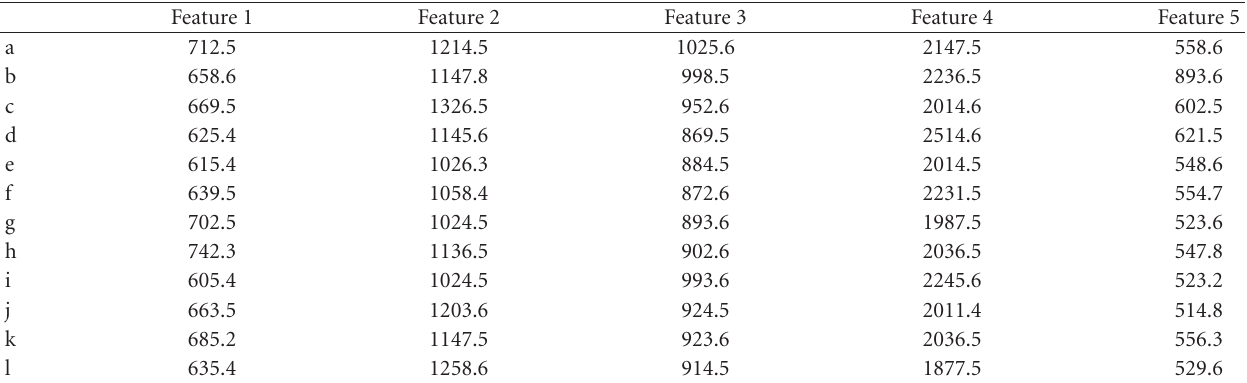
Table 6: Energy distribution surface features in trigonometry Bernstein-Bezier surface.